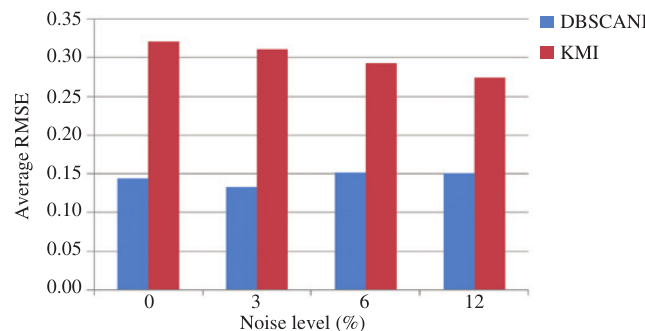
Figure 3: Average RMSE versus Noise Level for Iris Data Set.